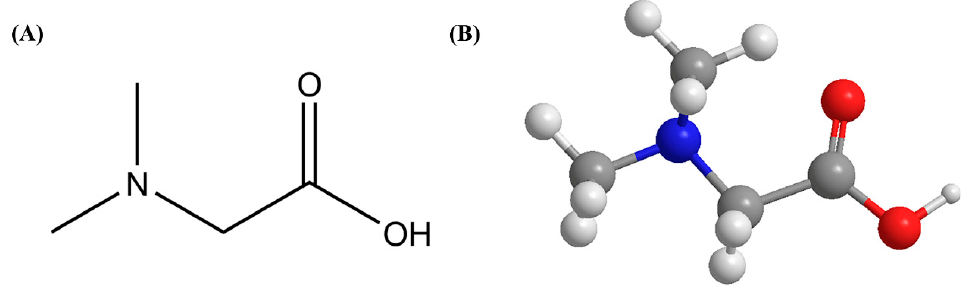
Figure 1. The 2D ( A ) and 3D ( B ) molecular structure of DMG.